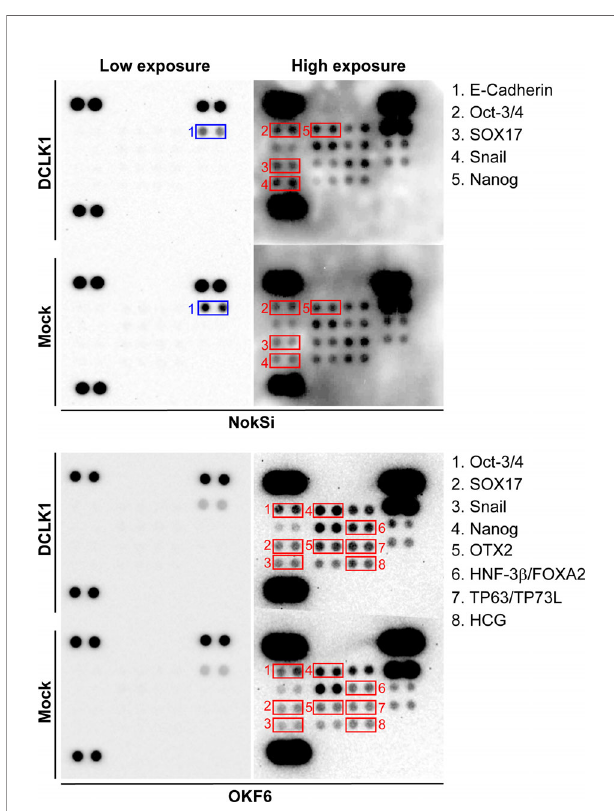
FIGURE 3 | DCLK1 overexpression induces upregulation of key stem cell biomarkers. Human stem cell antibody arrays were performed using whole lysates collected from DCLK1 overexpressing and control NokSi and OKF6 cell lines. Upregulated stem cells markers in the DCLK1 cell lines were highlighted in red boxes. Downregulated E-cadherin in NokSi cells expressing DCLK1 was highlighted in blue